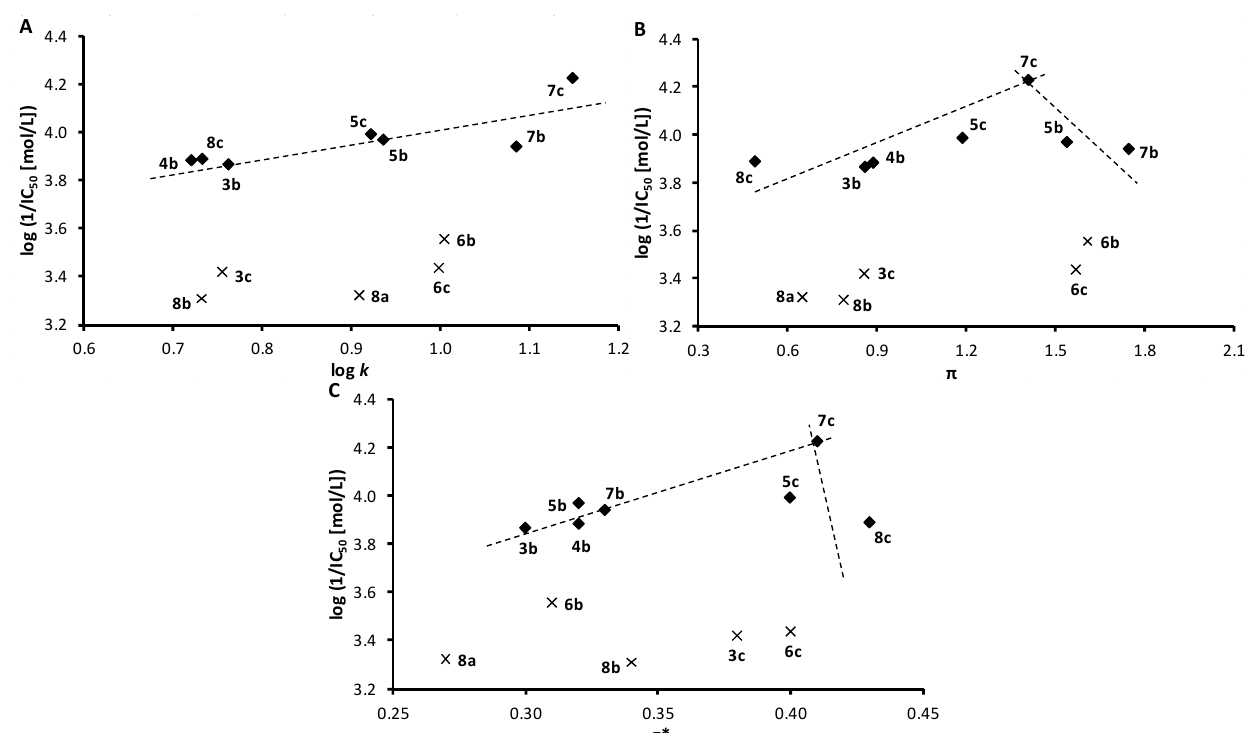
Figure 5. Relationships between PET inhibition log(1/IC chloroplasts and lipophilicity expressed as log k ( A ) or distributive parameter π ( B ), as well as polar substituent constants σ * ( C ) of selected studied compounds. ( π : hydrophobicity contribution of the substituent in position 1 of naphthalene, σ *: electron properties contribution of the substituent in position 1 of naphthalene; eliminated compounds 3c , 6b , 6c , 8a , 8b marked by crosses)